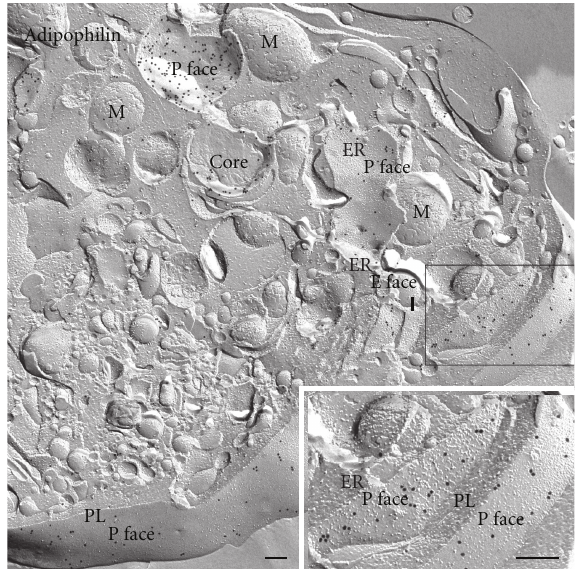
Figure 5: Adipophilin in cellular membranes. Survey freeze- fracture view of a lipid-laden macrophage immunogold-labeled for adipophilin. Apart from positive labeling in the periphery of lipid droplets prominent label is seen in the P face of the plasma membrane (PL) and ER membranes. The E faces of the ER, mitochondrial and vesicle membranes are devoid of label. Inset: higher magnification of the P face of ER and plasma membrane. M mitochondria. Bar: 0.2 μ m.